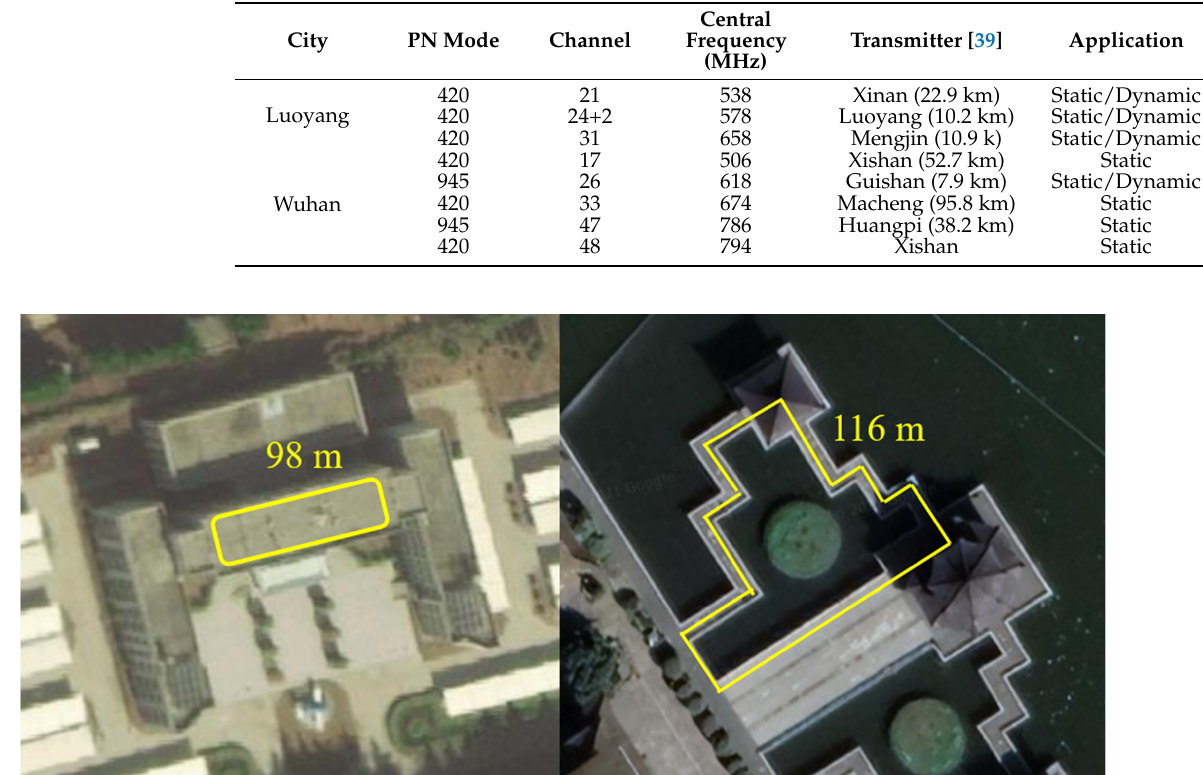
Figure 3. Walking trajectory in Luoyang ( left ) and Wuhan ( right ).